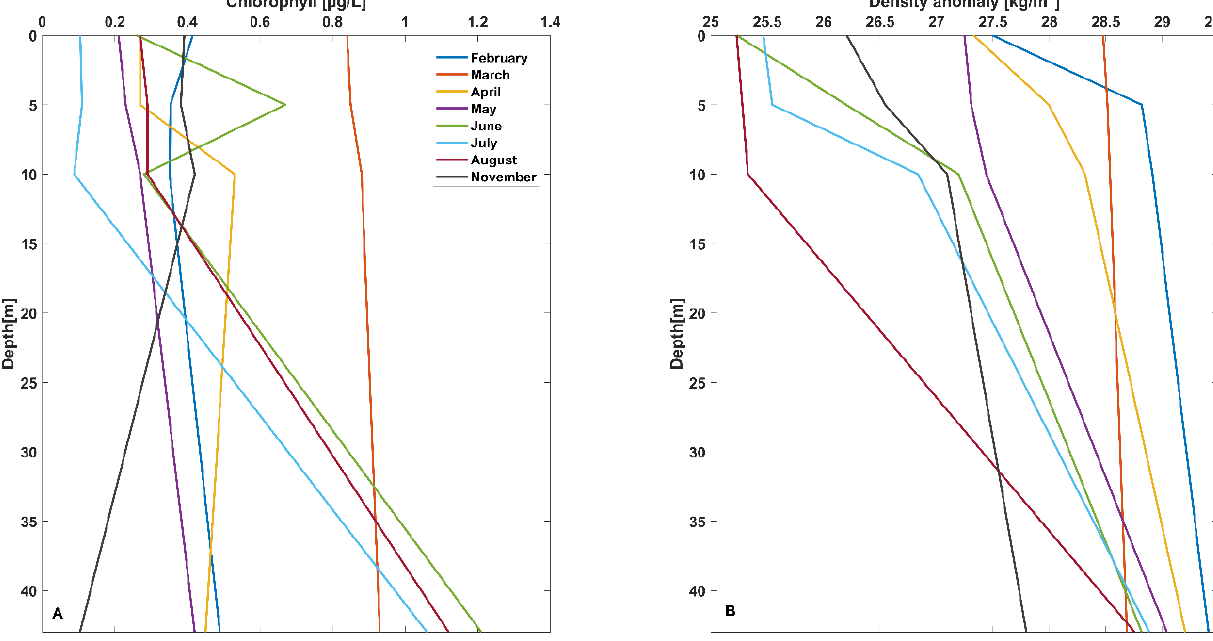
Figure 7. Geometric mean vertical chlorophyll ( A ) and density anomaly ( B ) concentrations observed during the 2012–2019 period at the measuring station, FP-O14b.